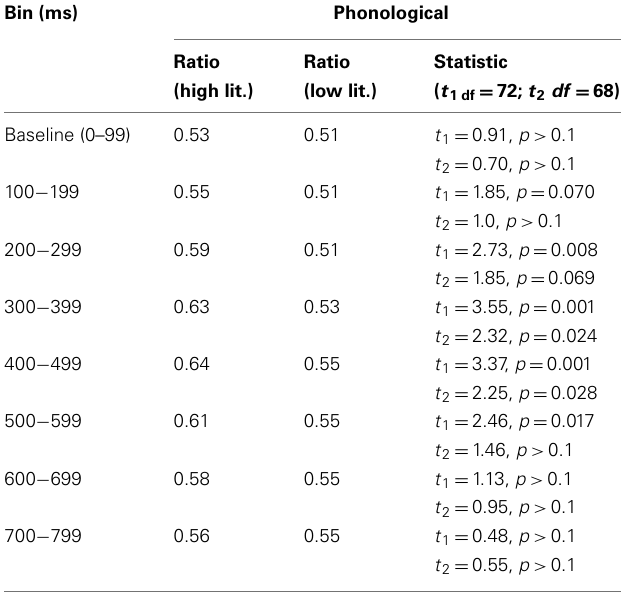
Table 2 | Group comparisons (Experiment